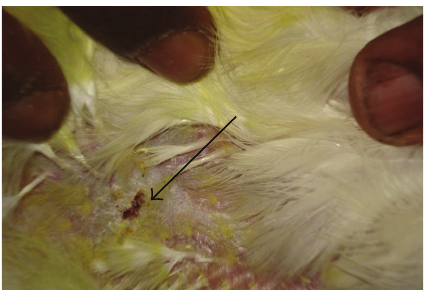
Figure 4: DTH reaction of skin (T-2 toxin fed bird): minimal skin thickness and scab formation.